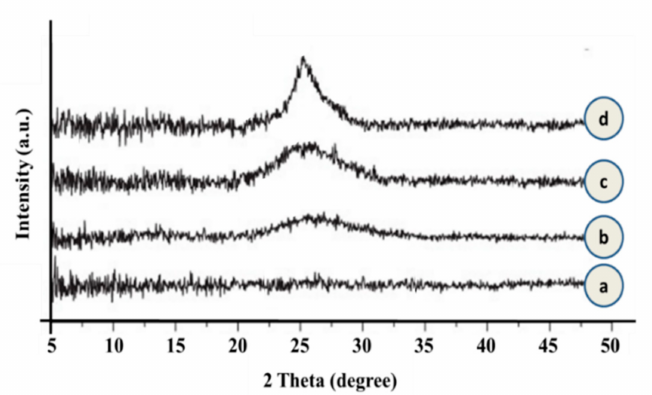
Figure 3. XRD patterns of ( a ) starch-PVA film, ( b ) starch-PVA loaded with 1% CNPs, ( c ) starch-PVA film loaded with 3% CNPs, and ( d ) starch-PVA film loaded with 5%